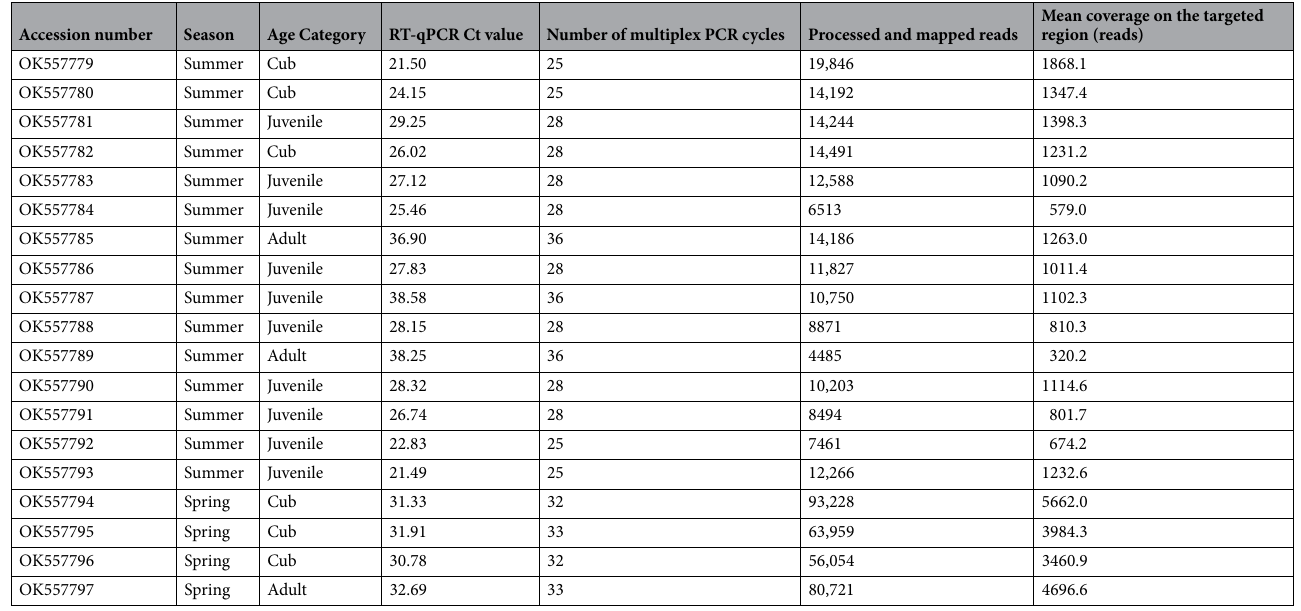
Table 1. Sequencing and diagnostic parameters of the investigated fox samples. Most relevant next-generation sequencing quality data as the mapped reads and mean coverage per sample is presented. Number of multiplex PCR cycles is relevant for the amplicon-based NGS sequencing